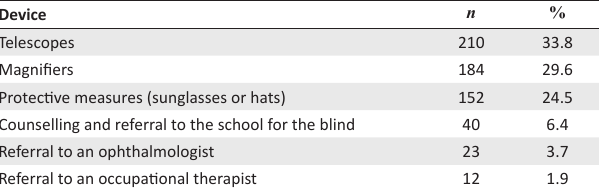
TABLE 5: The recommended interventions for 621 patients seen at the low vision clinic of the Department of Optometry, University of KwaZulu-Natal. Device n % Telescopes Protective measures (sunglasses or hats)